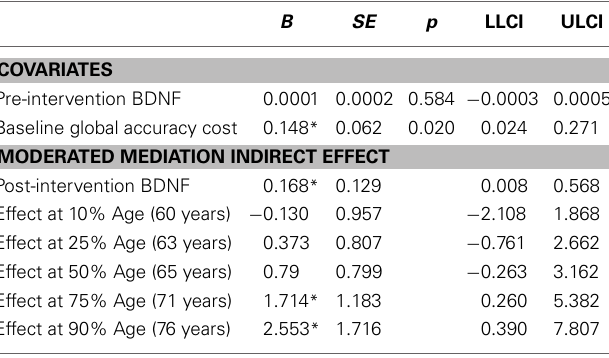
Table 5 | Moderated mediation model of effects of exercise group on global accuracy cost.